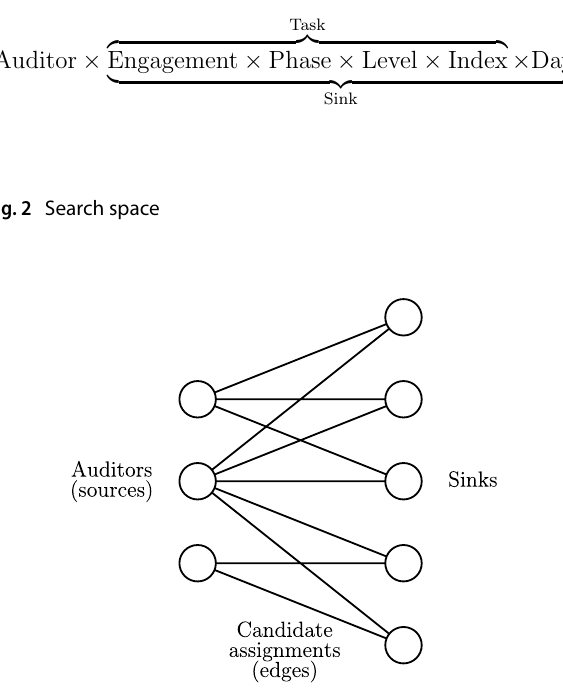
Fig. 2 Search space